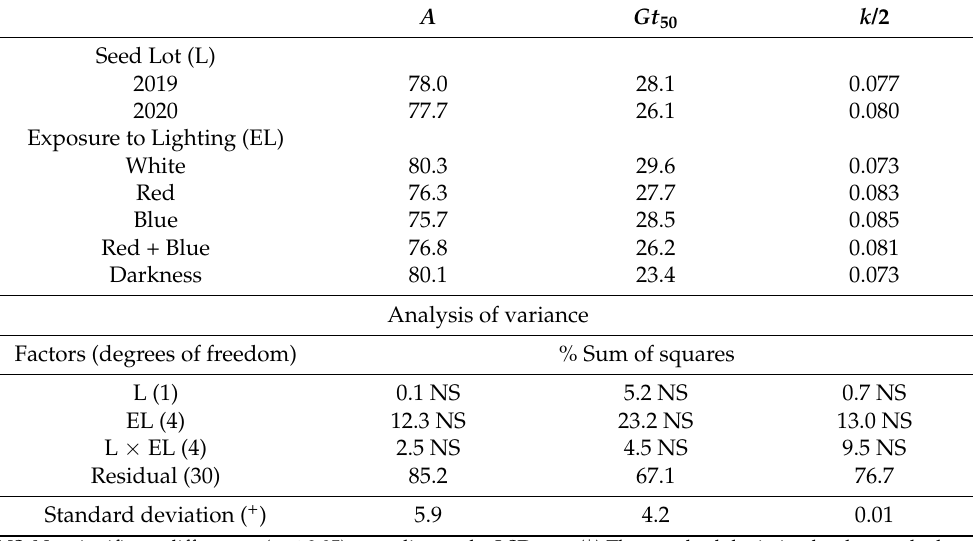
Table 3. Effect of the seed lot and the exposure to white, red, blue or red + blue lights and to darkness on the germination parameters: final germination percentage ( A , %), time required to reach 50% of final germination ( Gt 50 ; d), and average germination rate ( k /2; d − 1 ); average values from